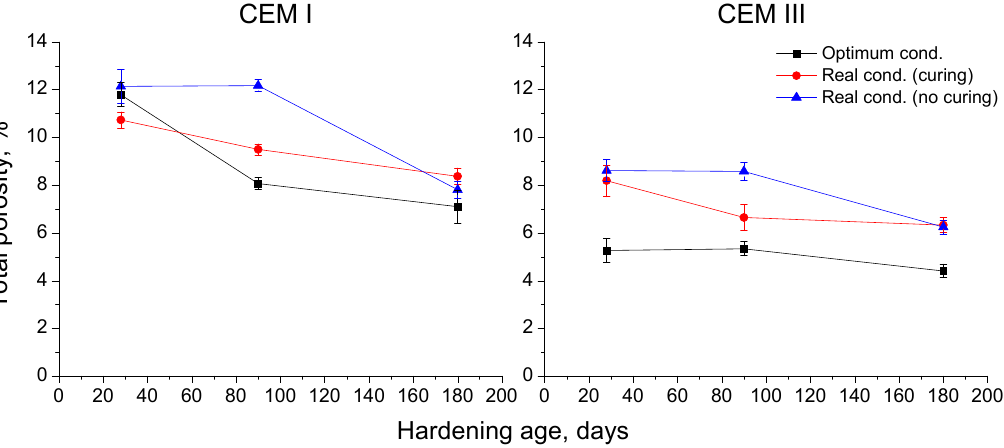
Figure 4. Results of total porosity for CEM I and III concrete specimens.